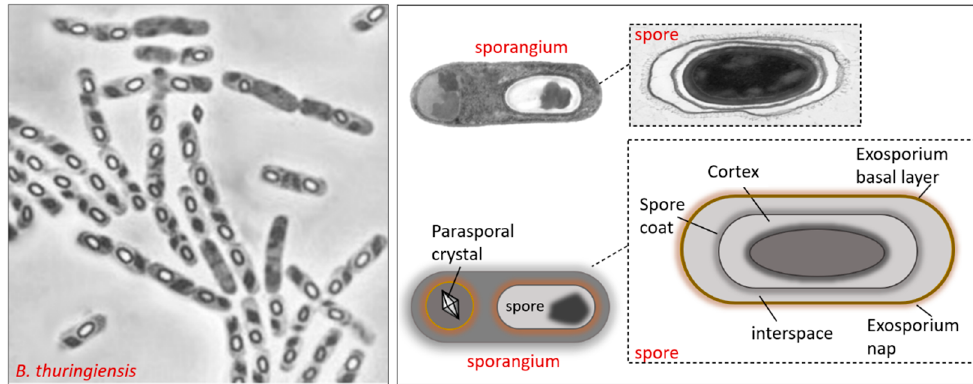
Figure 3. B. thuringiensis sporangium containing the spore and parasporal inclusion with toxins crystal. The spore and paraspore are protected by the presence of the exosporium during interaction with the host midgut environment.